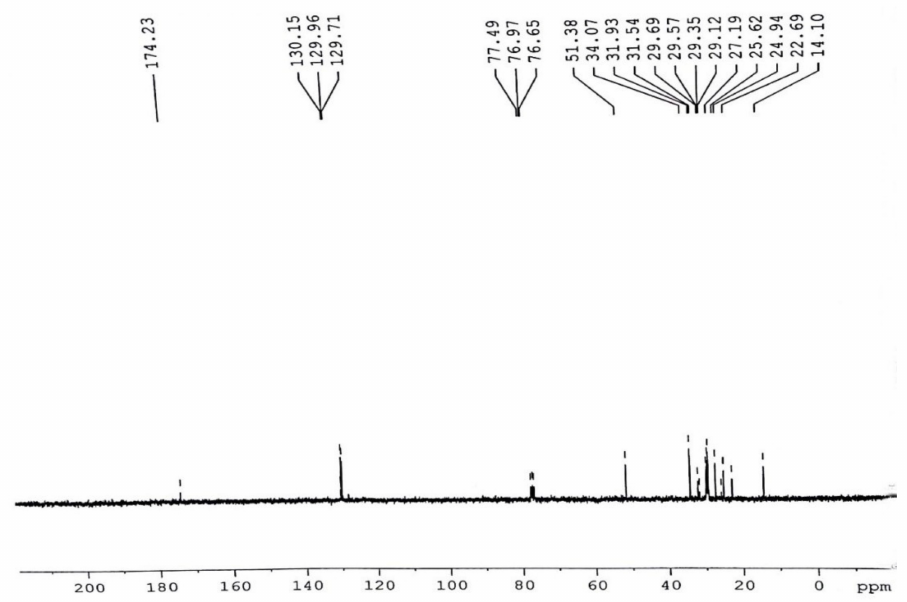
Figure 21. 13 C NMR spectrum of Prunus aitchisonii seed oil biodiesel treated with